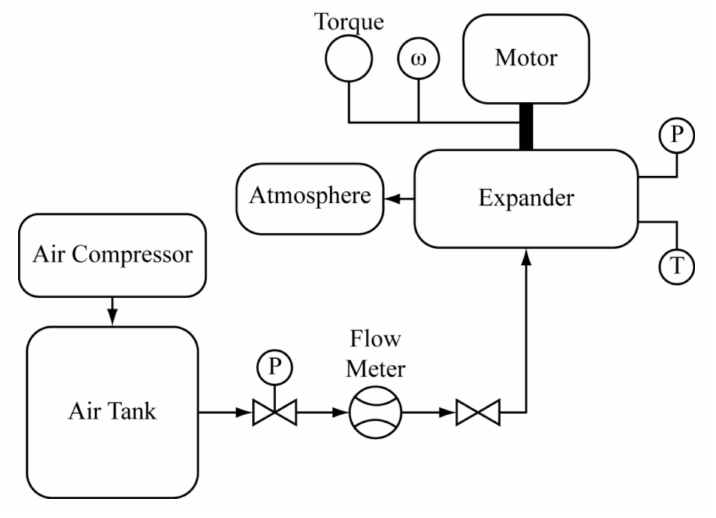
Figure 3. Expander experiment schematic [33].